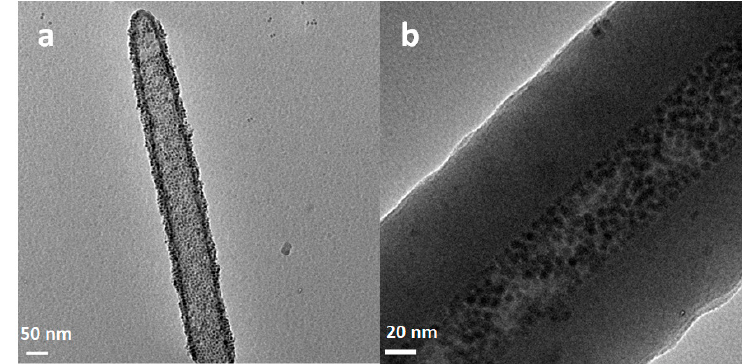
Figure 9. TEM images of ( a ) 4 nm Fe 3 O 4 nanocrystals loaded into 10 nm shell SiNTs; ( b ) 4 nm Fe 3 O 4 nanocrystals loaded in 70 nm thick